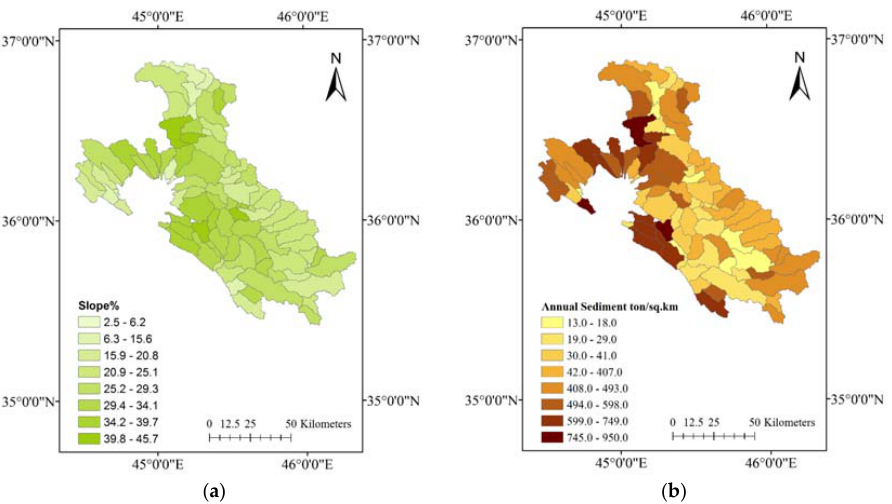
Figure 8. ( a ) Spatial distribution of average annual sediment load for the Dokan watershed sub basins; ( b ) average slope of sub basins.